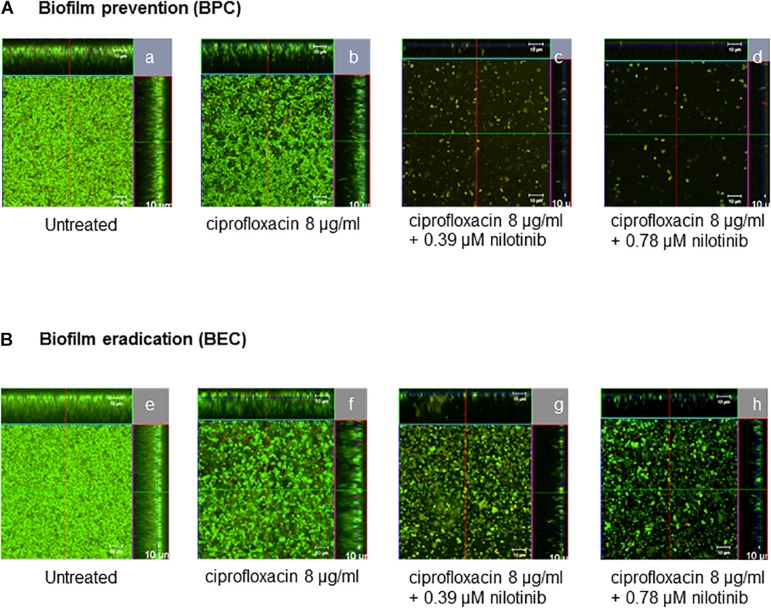
Confocal laser scanning microscopy ortho-images of LIVE/DEAD®-stained S. aureus SA1199B biofilms. The x/y planes correspond to the top views on basal biofilm layers and the marginal images corresponds to the cross-sections of the biofilms for (A) BPC and (B) BEC: (a,e) biofilms without treatment, (b,f) treatment with 8 μg/mL ciprofloxacin, (c,g) treatment with 8 μg/mL of ciprofloxacin in combination with 0.39 μM of nilotinib, and (d,h) treatment with 8 μg/mL ciprofloxacin in combination with 0.78 μM of nilotinib. Viable bacteria are visible in green and dead bacteria in red. The images are representative of three independent experiments.